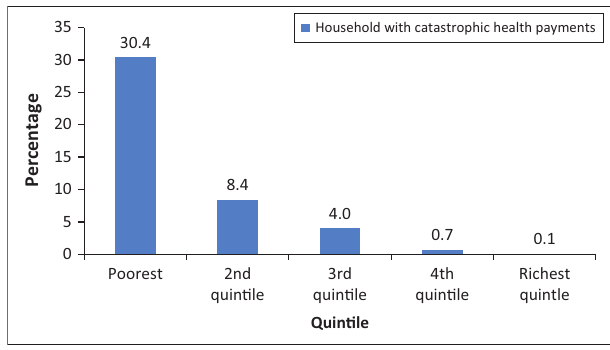
FIGURE 2: Proportion of households facing catastrophic expenditures by expenditure